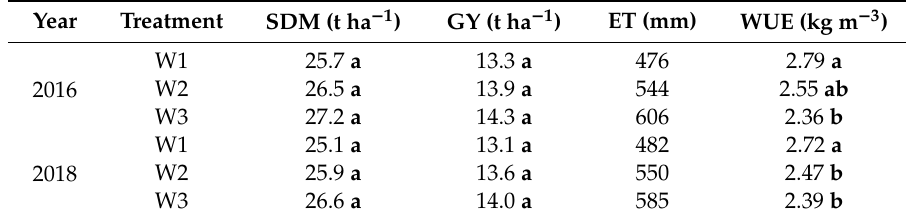
Table 4. Final shoot dry matter (SDM), grain yield (GY), actual crop water consumption (ET) and water use e ffi ciency (WUE) of spring maize under irrigation treatments in 2016 and